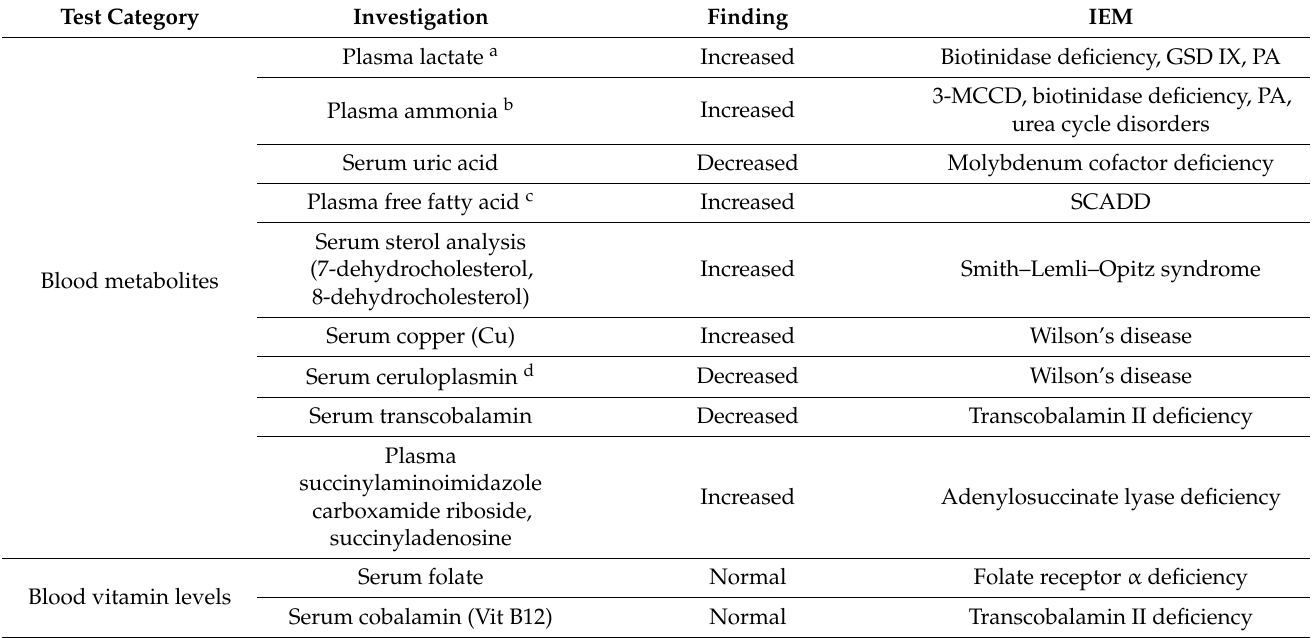
Table 3. Metabolic work-up [100–108]. (3-MCCD: 3-methylcrotonyl-CoA carboxylase